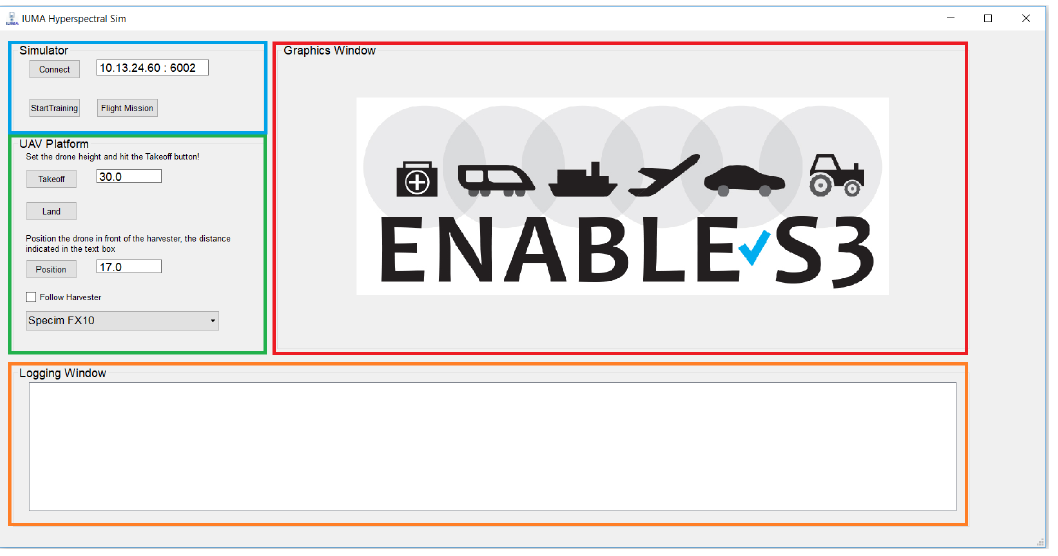
Figure 5. Hyperspectral imaging tool windows.